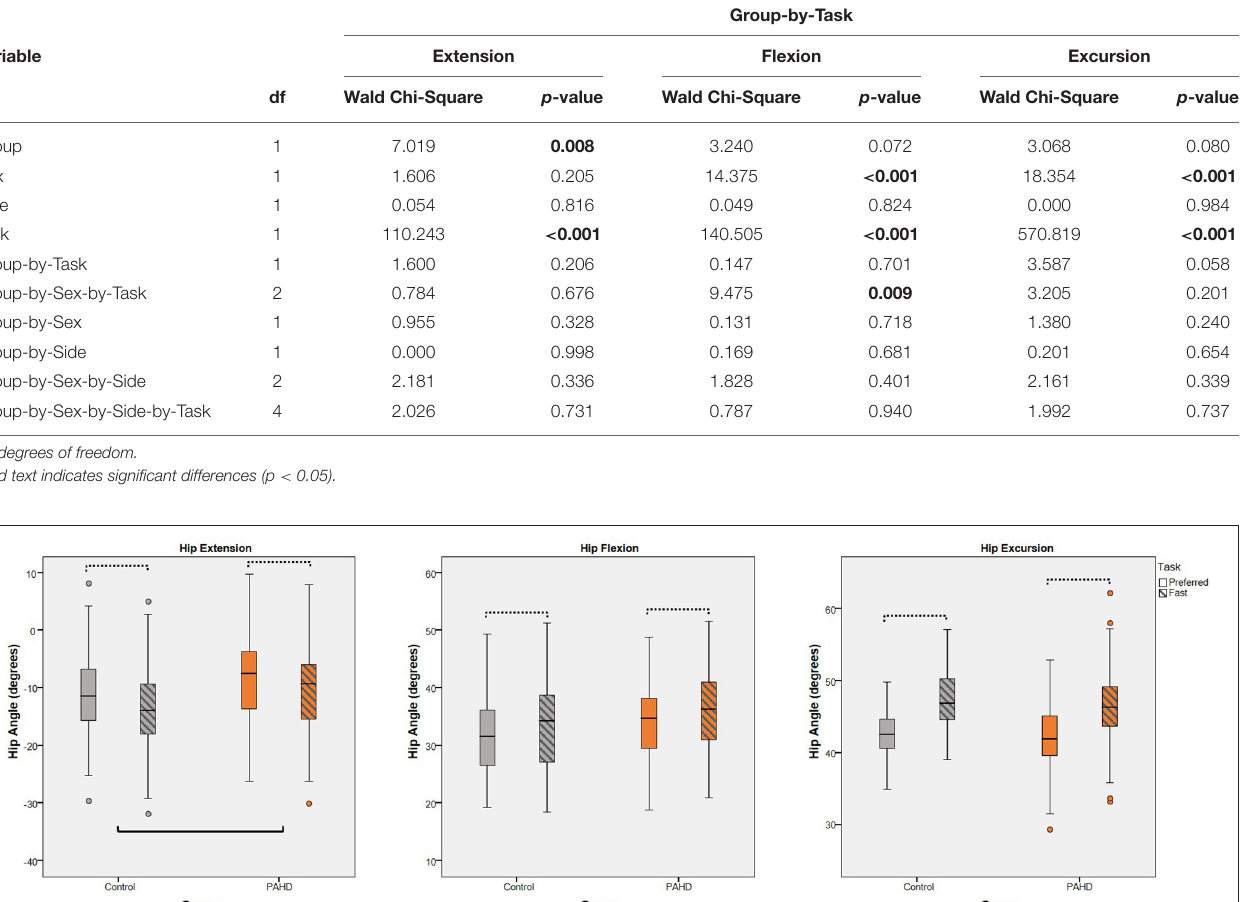
TABLE 4 | Results of linear regression with generalized estimating equation correction for each dependent variable (hip extension, flexion, and excursion) modeling the interaction of group (PAHD, Control) and task (preferred speed, fast speed).